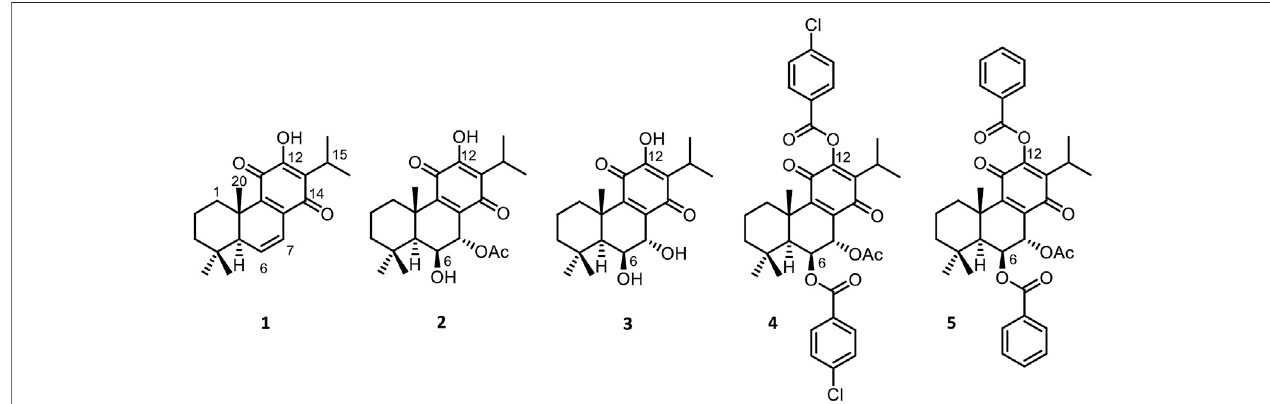
FIGURE 1 | Natural and semisynthetic royleanones: 6,7-dehydroroyleanone (1) and 7 α -acetoxy-6 β -hydroxyroyleanone (2), 6,7-dihydroxyroyleanone ( 3 ), 7 α - acetoxy-6 β -benzoyloxy-12- O -(4-chloro)benzoylroyleanone ( 4 ) and 7 α -acetoxy-6 β -benzoyloxy-12- O -benzoylroyleanone ( 5 ).